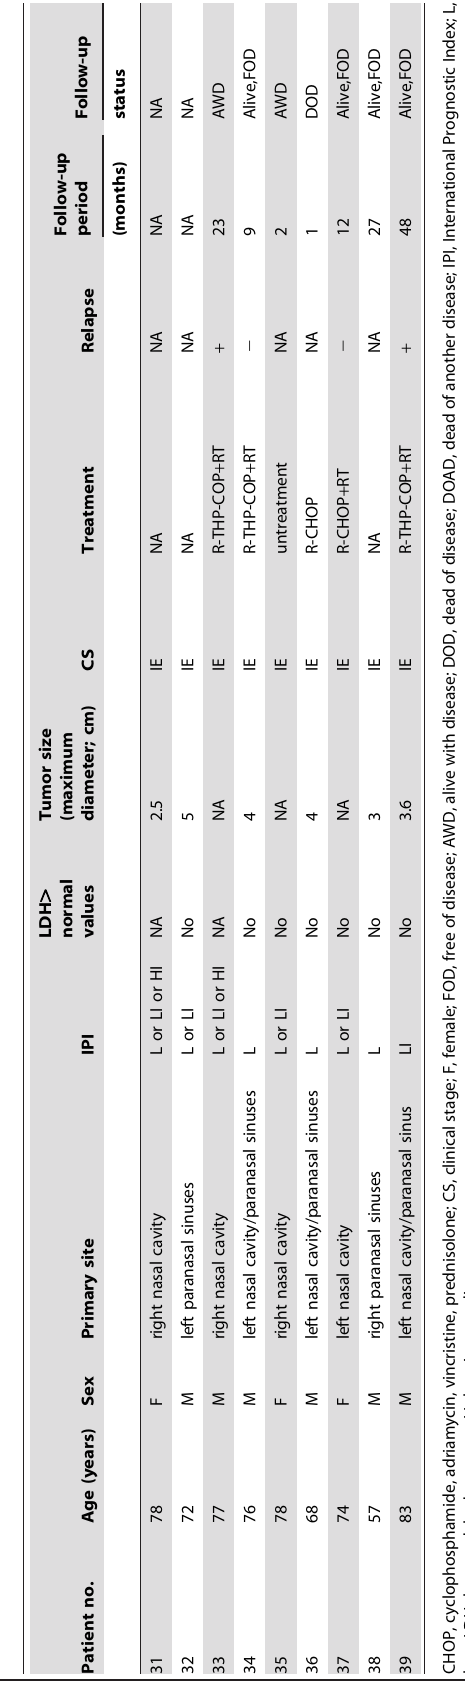
Table 2. Clinical characteristics of patients with localized nasal/paranasal